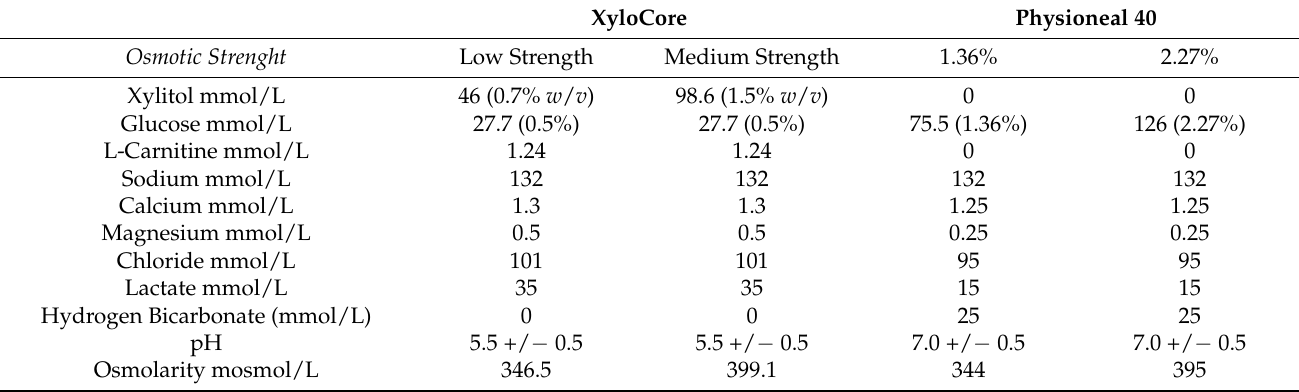
Table 1. Composition of peritoneal dialysis